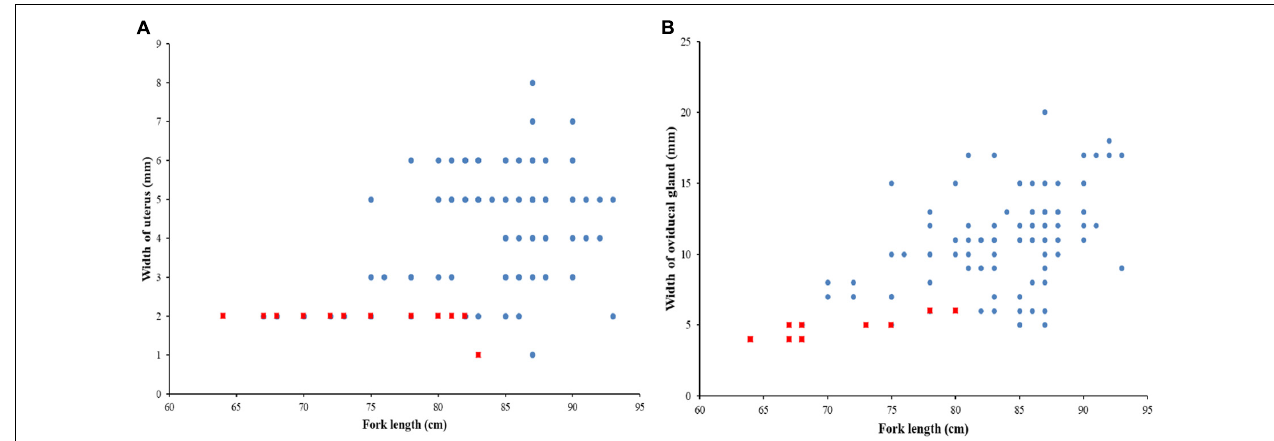
FIGURE 9 | Relationship between fork length and, (a) width of the uterus; and (b) oviducal gland for P. kamoharai , from the Tropical Eastern Atlantic. Red dots represent immature specimens; Blue dots represent mature specimens.